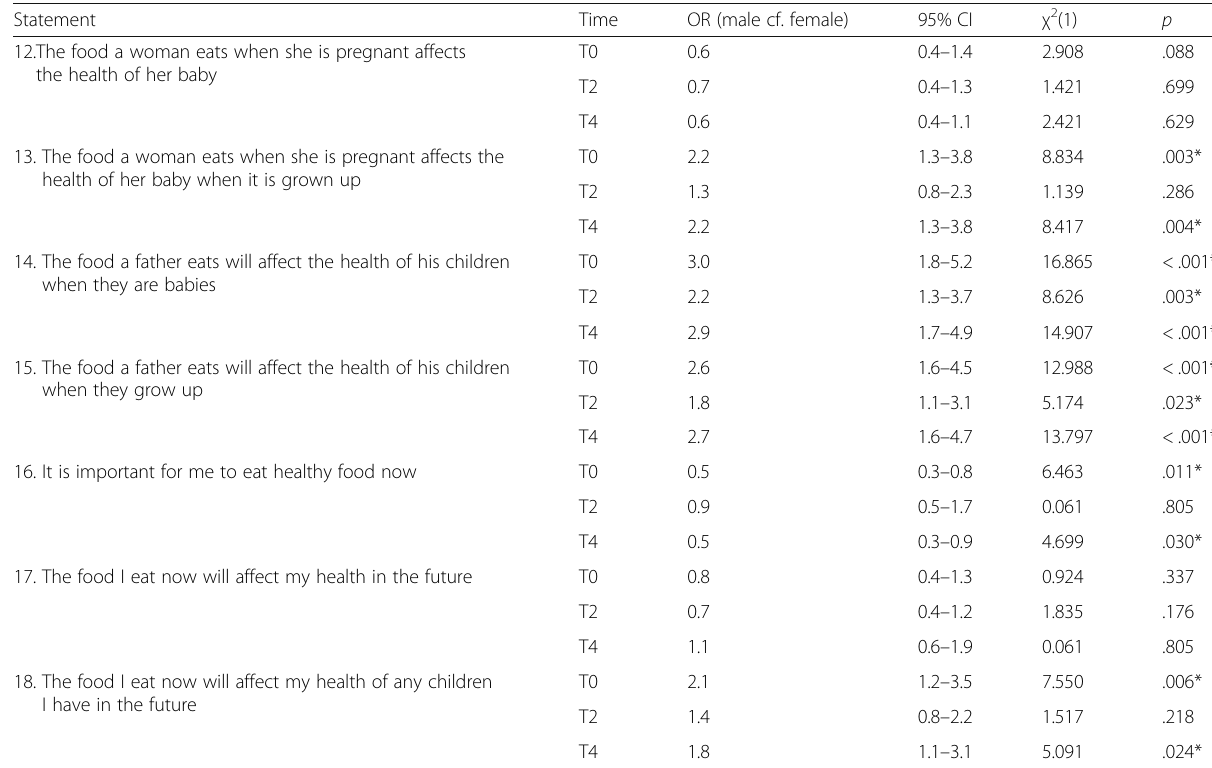
Table 5 Odds ratio (95% CI), awareness of associations between nutrition and health across the life course male compared to female